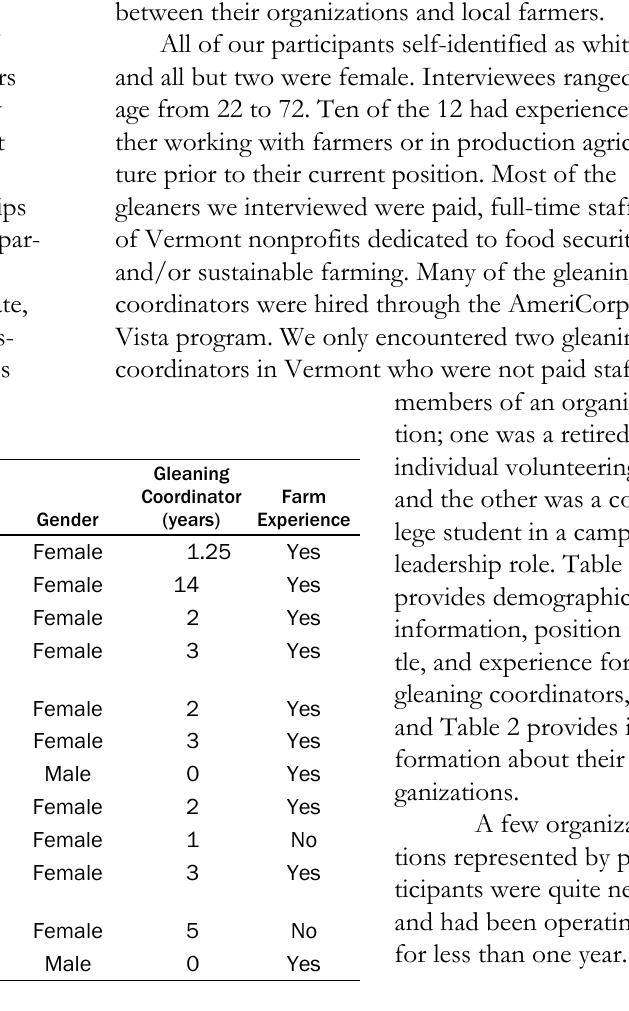
Table 2. Gleaning Organization